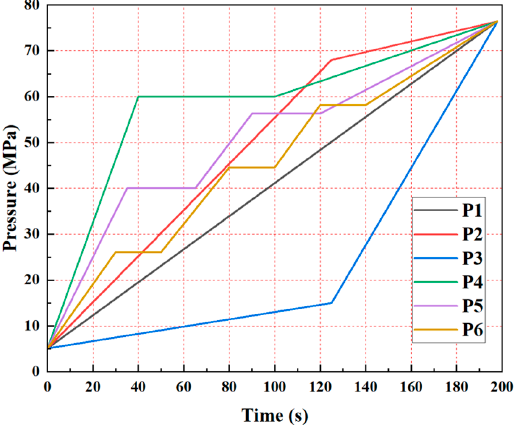
Figure 16. Six inlet pressure rise pa tt erns for the cylinders.